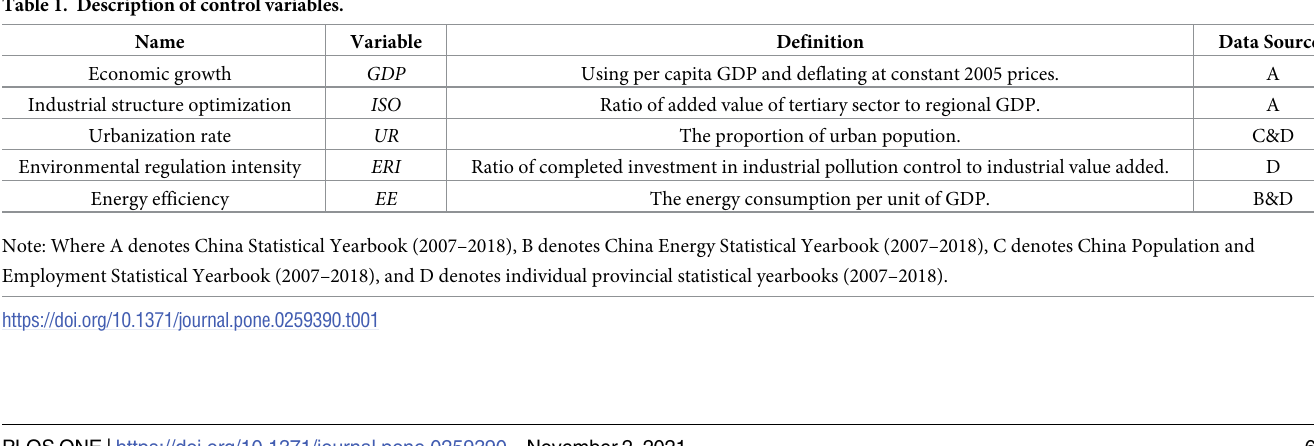
Granger non-causality test. From the results in Table 2, the urban-rural income gap is the